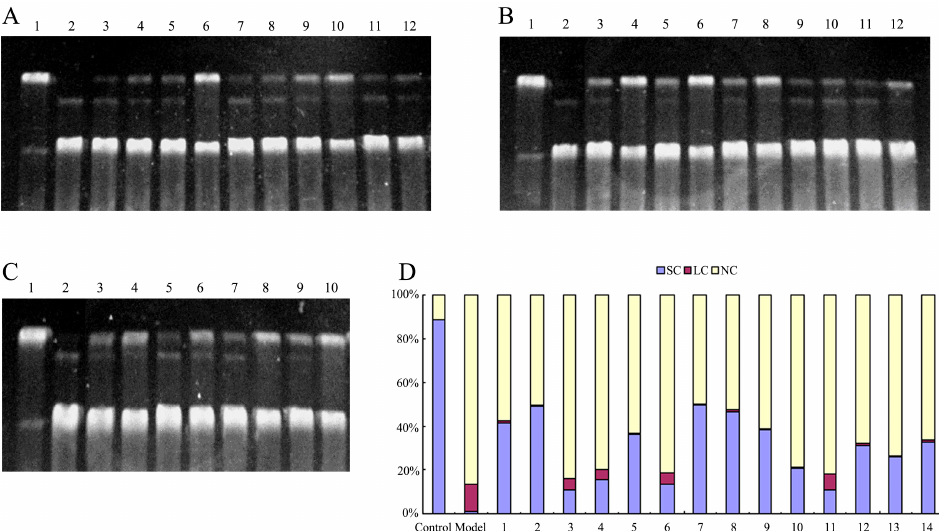
Figure 2. Protective effect of flavonoids from Agrimonia pilosa Ledeb against pBR322 DNA cleavage induced by oxidative injury. ( A ) Agarose gel electrophoresis. Lane 1: DNA control; lane 2: Model, H 2 O 2 , 100 mM; lanes 3, 4: Quercetin, 0.1 mM, 1.0 mM; lanes 5, 6: Taxifolin, 0.1 mM, 1.0 mM; lanes 7, 8: Kaempferol, 0.1 mM, 1.0 mM; lanes 9, 10: Luteolin, 0.1 mM, 1.0 mM; lanes 11, 12: Apigenin, 0.1 mM,